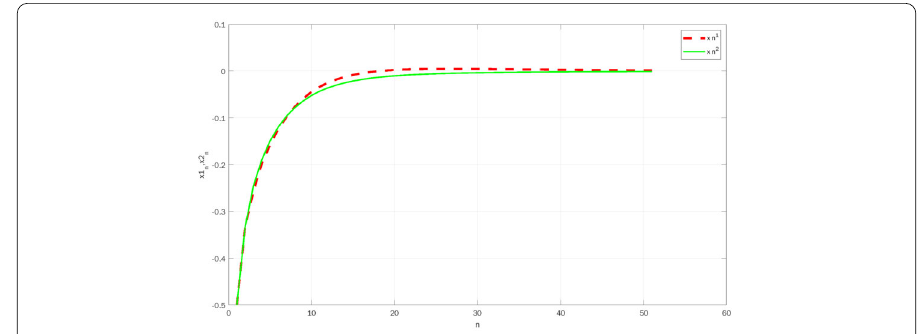
Figure 2 The convergence of { x n } with x 1 = (–0.5,–0.5) and n = N =